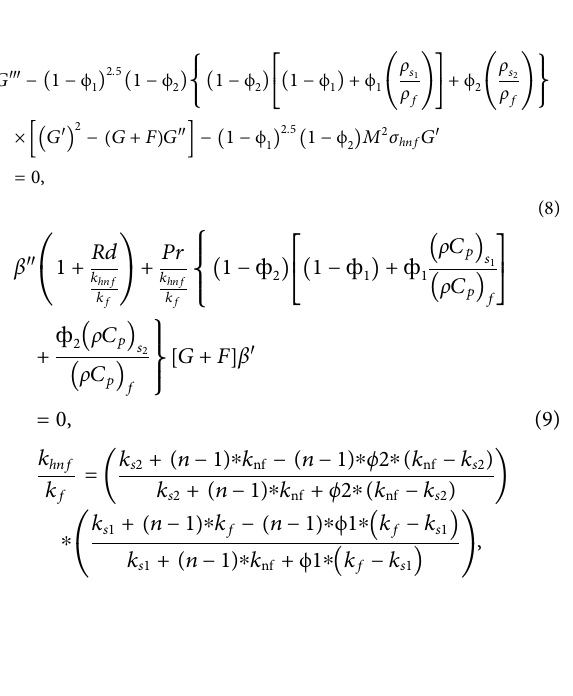
FIGURE 2 Implementation process of the